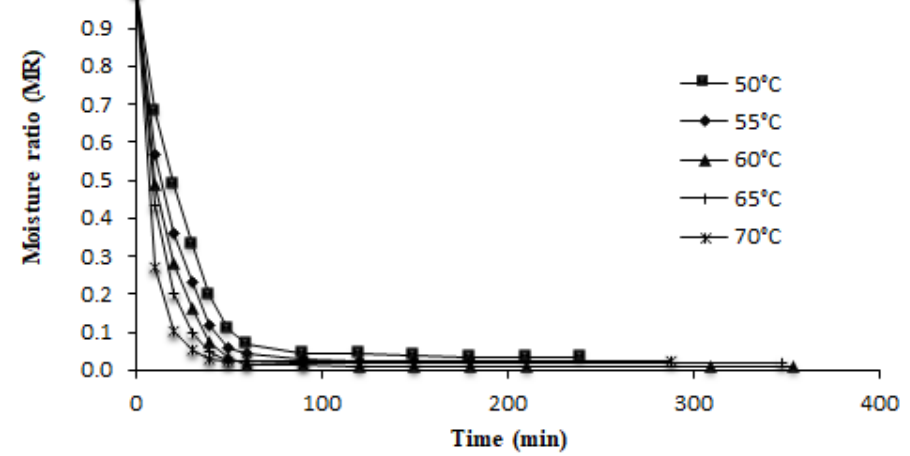
Figure 1. Moisture ratio vs. drying time at different air temperatures for wheatgrass